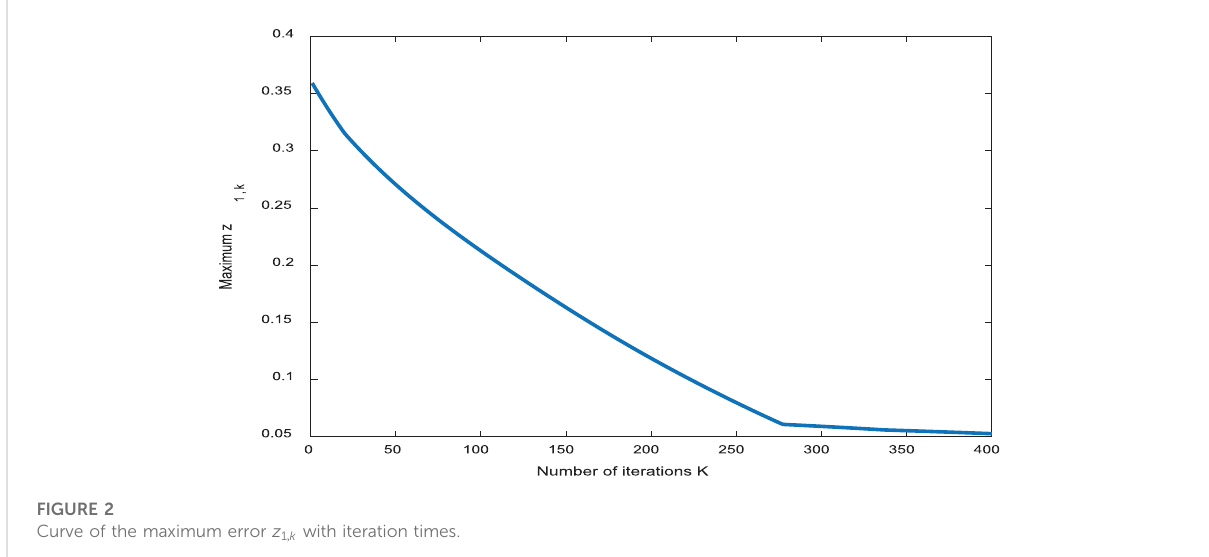
FIGURE 2 Curve of the maximum error z 1 , k with iteration times.